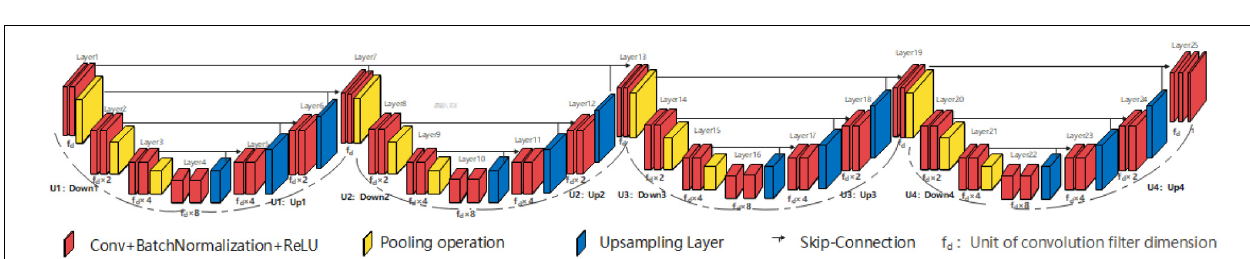
FIGURE 4 | Structure diagram of double high peak horizontal EUNet (DHP-horizontal EUNet) U 1 (4-4)-U 2 (4-4)-U 3 (4-4).